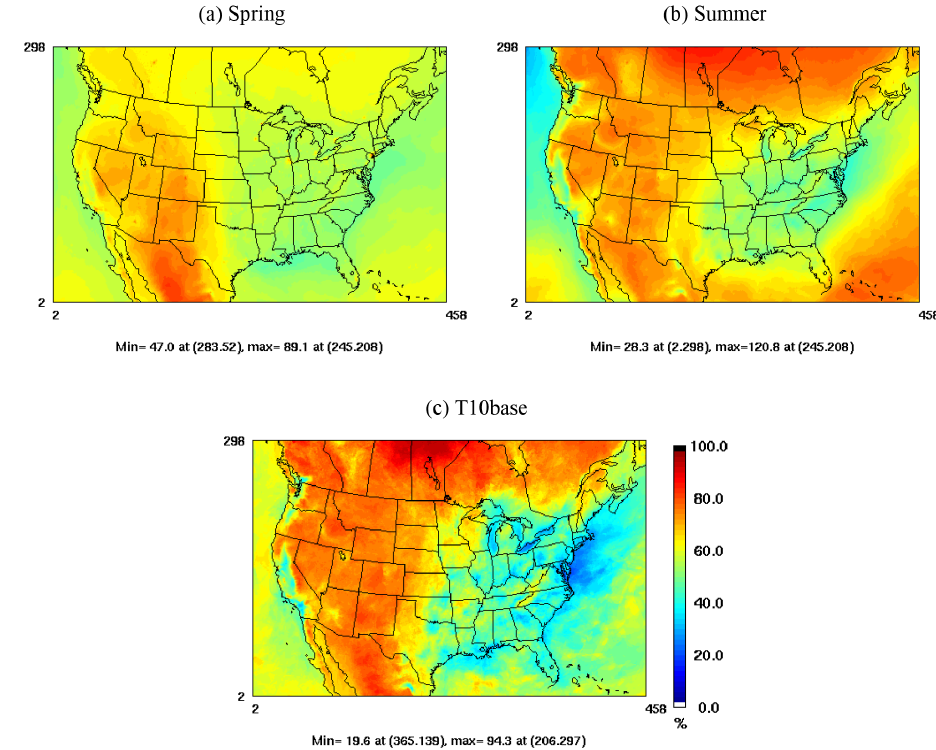
Figure 8. Ratio of the background MDA8 O 3 to the base-case MDA8 O 3 for (a) spring, (b) summer, and (c) T10base averages.